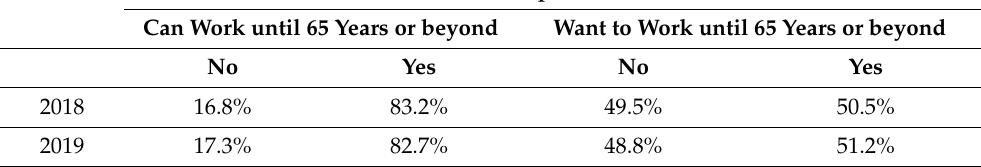
Table 1. School principals’ statements regarding whether they “Can work” or “Want to work” until 65 years of age and beyond in 2018 and in 2019. (no = can/want only to work until 55 to 64 years of age; yes = I can/want to work 65 years or